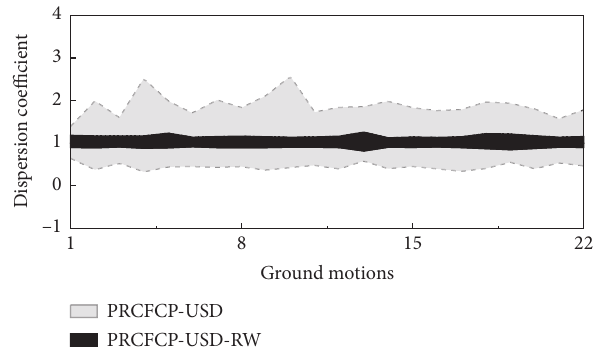
Figure 13: Dispersion coefficients of the USDs energy dissipation under 22 ground motions.